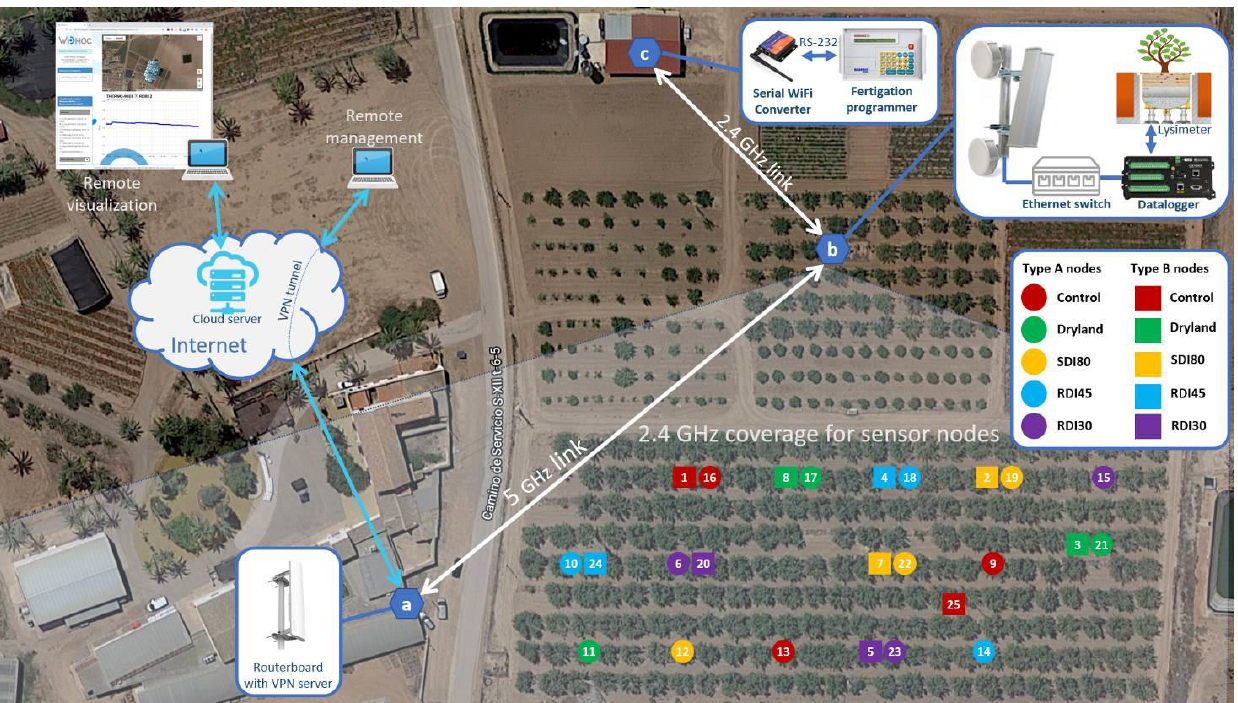
Figure 1. WSN infrastructure of the experimental orchard.